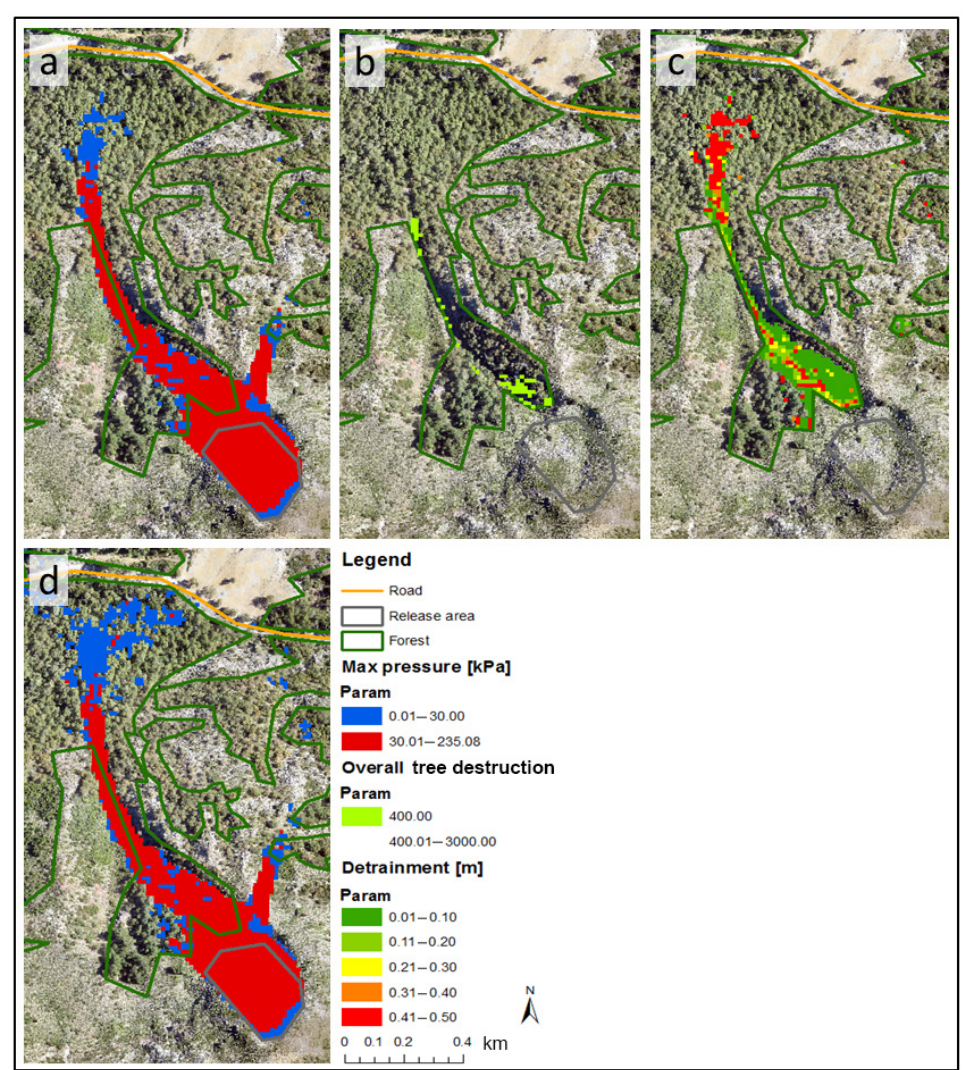
Figure 7. Avalanche simulations at avalanche track 9 with a 10-year return period: (a) maximum pressure of an avalanche scenario with forest, (b) area where forest is destroyed, (c) detrainment in the forest and (d) the maximum pressure of an avalanche scenario without considering